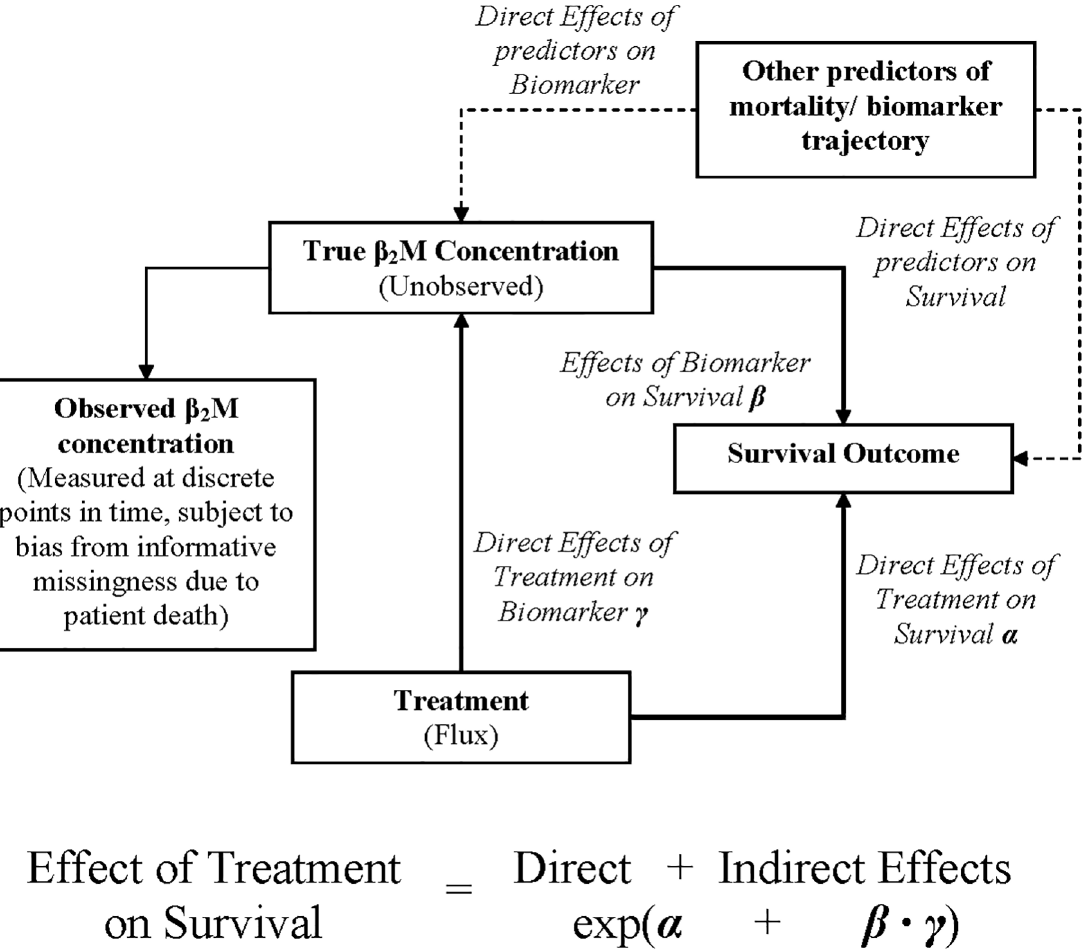
Fig 1. Conceptual depiction of the Joint Modeling Framework. A joint model is an analytical method for the simultaneous estimation of treatment effects on survival outcomes, the effects of treatment on the concentration of a biomarker over time (trajectory function) and the effects of the latter on survival. As the true biomarker level is unobserved, a JM has to reconstruct its trajectory before these effects can be estimated. Other factors may affect survival either directly or indirectly (through the biomarker concentration) and they can be used to adjust a JM and thus reduce residual confounding. One possible interpretation of the fitted joint model effects on survival assigns direct treatment effects (not associated with changes in the biomarker trajectory, α ) and indirect treatment effects (associated with changes in the biomarker concentration, given by the product of β and γ ). Hence, the overall treatment effect in the Hazard Ratio scale is the (exponentiated) sum of direct and indirect effects. This effect is usually numerically similar to the one estimated by a Cox